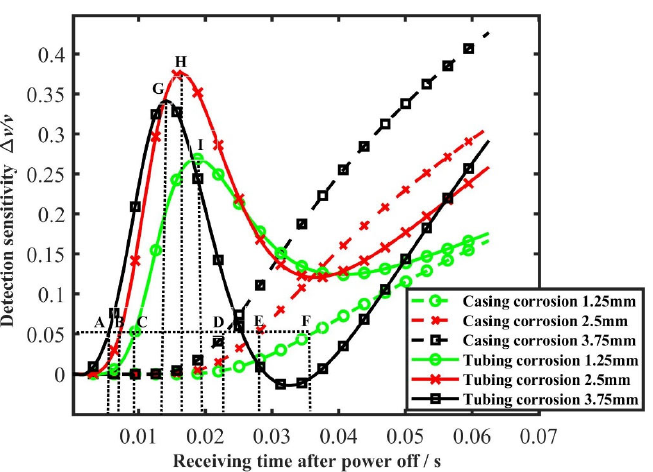
Table 1. 5% time and peak time of sensitivity time slice curves for different corrosions in the simu ‐ lation.